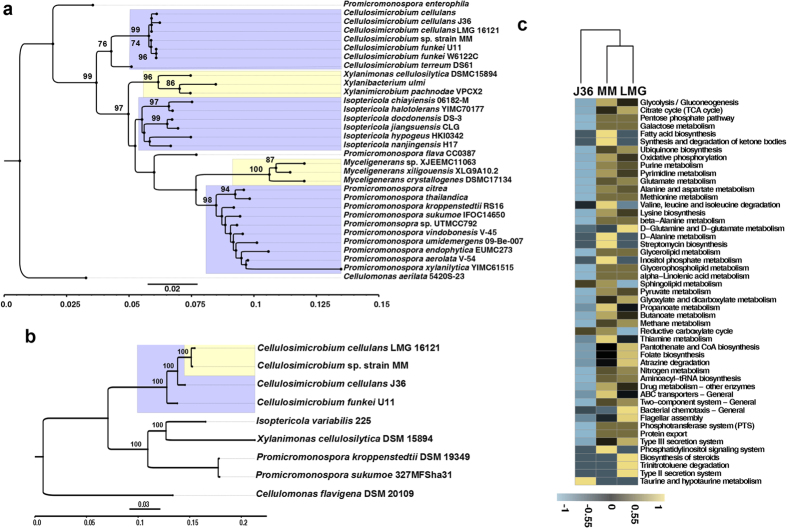
Phylogenomic analysis and comparative functional potential of Cellulosimicrobium strains.(a) Rooted Maximum likelihood tree based on Jukes-Cantor model for family Promicromonosporacae using 31 16S rRNA gene sequences with Cellulomonas aerilata 5420S-23 as outgroup, (b) Rooted tree based on 31 single copy genes from 7 whole genomes using Cellulosmonas flavigena DSM 20109 as outgroup. All the trees are drawn to scale, with branch lengths measured in the number of substitutions per site. The percentage (> 70%) of replicate trees in which the associated taxa clustered together in the bootstrap test (1000 replicates) are shown next to the branches. (c) Heatmap with column dendrogram showing top 50 metabolic pathways reconstructed between three Cellulosimicrobium genomes i.e. strains MM, LMG16121, and J36. Three strains were clustered based on functional pathways using Manhattan distance metric, top 50 pathways with standard deviation 0.4 and having at least 0.8% of the total abundance were selected. Colour scale is representing the relative abundance of each functional pathway.